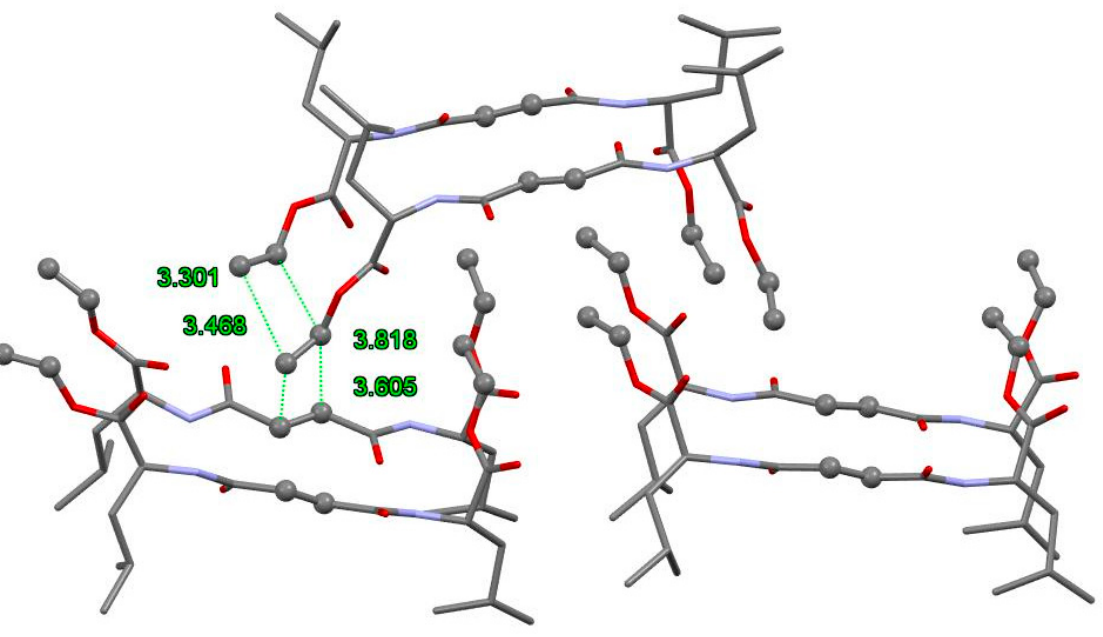
Figure 5. Favorable packing of the molecules 1a for polymerization reactions obtained by molecular modelling. Reactive olefin carbons are represented in a ball-and-stick model. Hydrogen atoms are omitted for clarity.